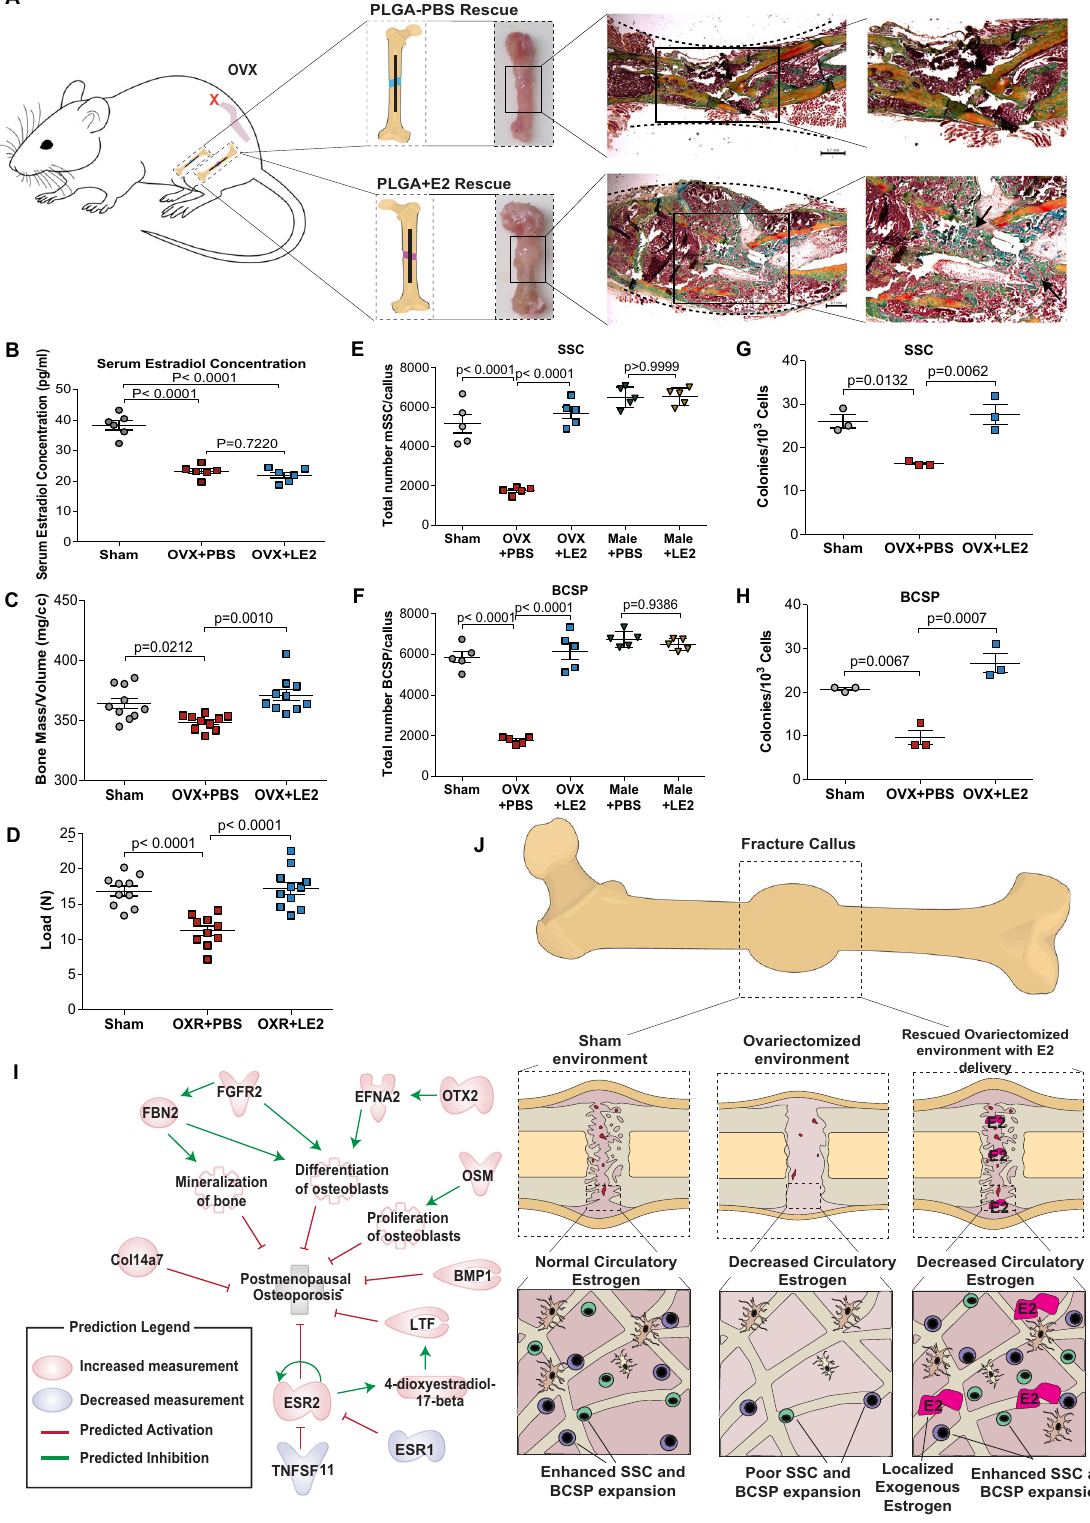
medullary cavity wasreamed using a 25-gauge needle, beforeinsertion of an intramedullary pin. A complete transverse, mid-diaphyseal frac- ture was made using microscissors. The pin remained in situ to stabi- lize the fracture to guide union. The patellawas relocated, the muscles re-approximated, and the skin closed with 6-0 nylon